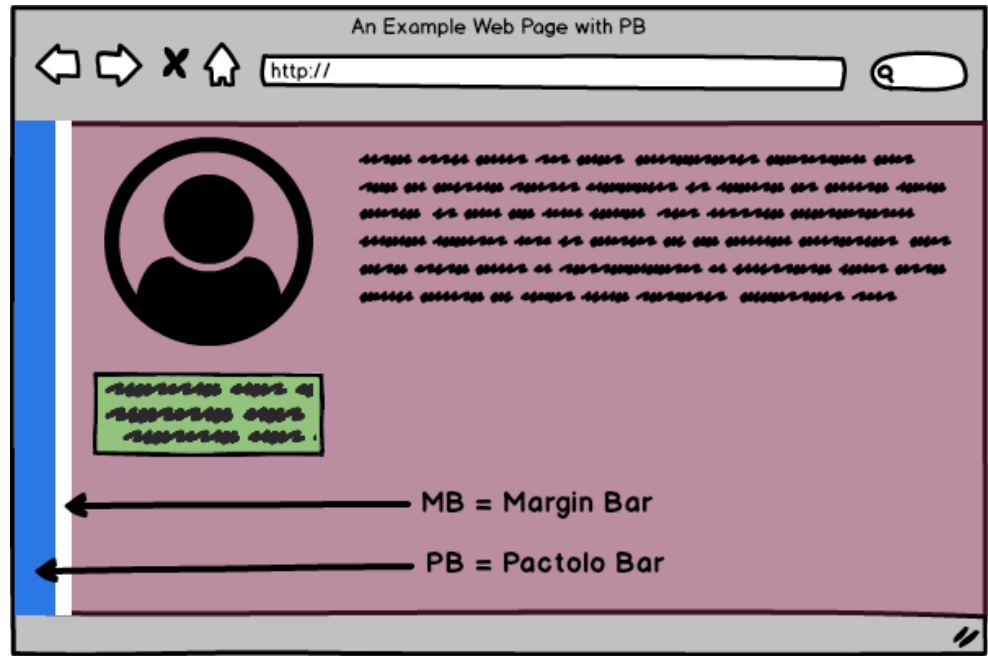
Figure 1. Representation of the Pactolo Bar running in a web page.